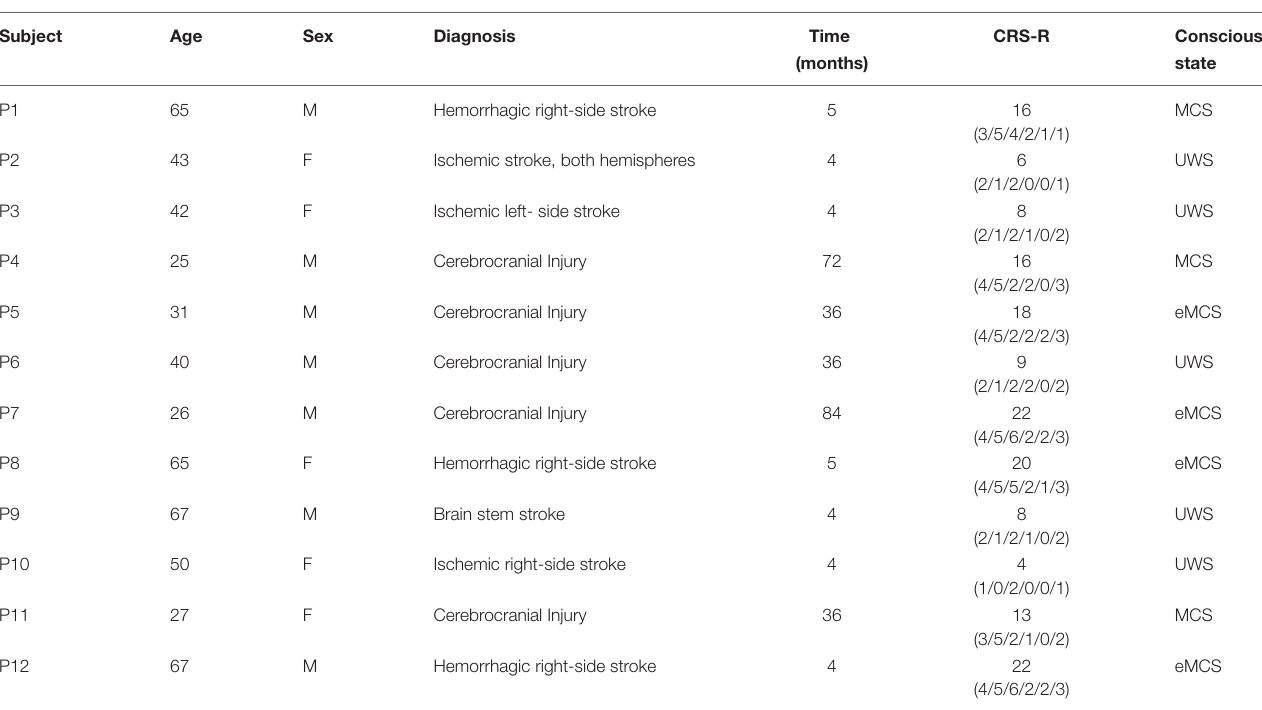
TABLE 1 | Characteristics of the study group. Characteristics